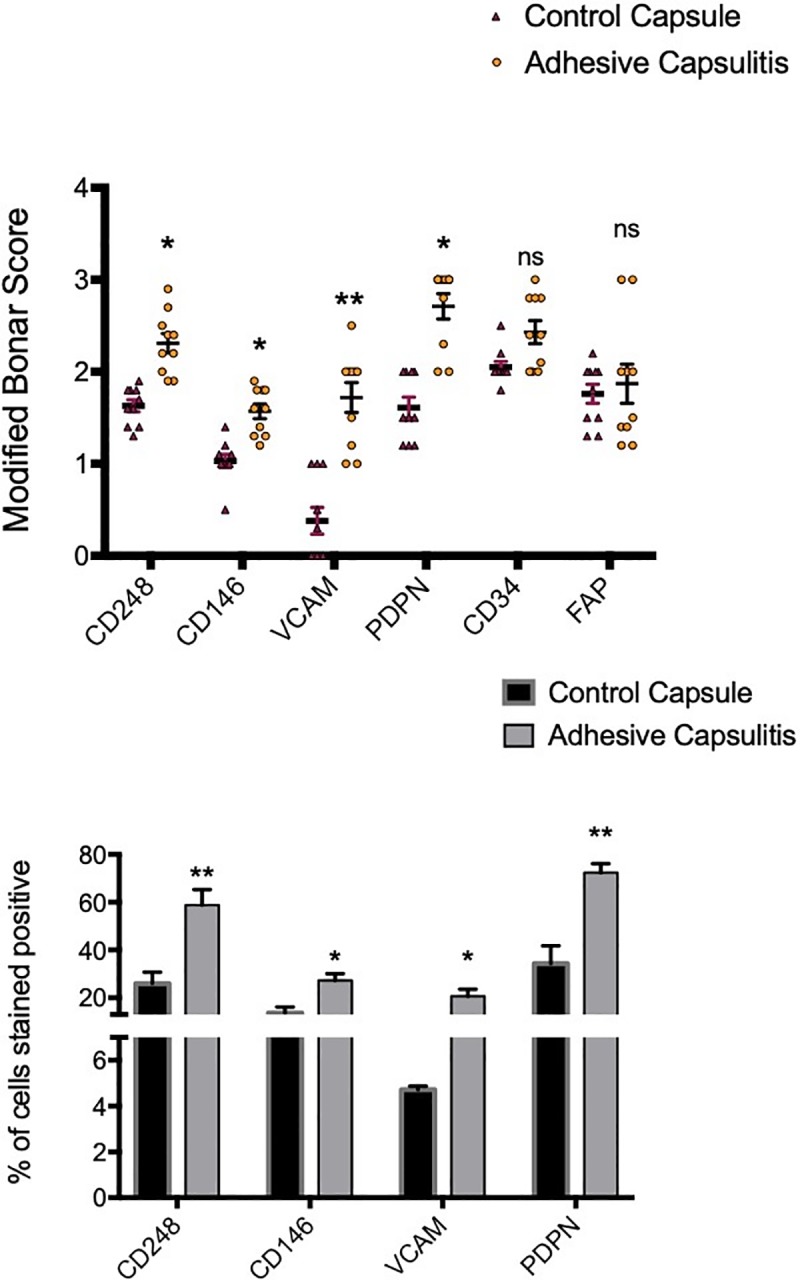
Fibroblast activation marker expression in control capsule and frozen shoulder.Graphs illustrate Modified Bonar scoring & % of cells positively stained for samples of human capsule biopsies for expression of CD248, CD146, VCAM, PDPN, CD34 and FAP, mean ± SEM, n  =  10 for control capsule, n  =  10 for frozen shoulder capsule. Modified Bonar scoring system depicts mean score per sample based on 10 high power fields. 0  =  no staining, 1  =  <10%, 2  =  10–20%, 3  =  >20% + ve staining of cells per high power field. *p < 0.05, **p < 0.01 (Students t-test).